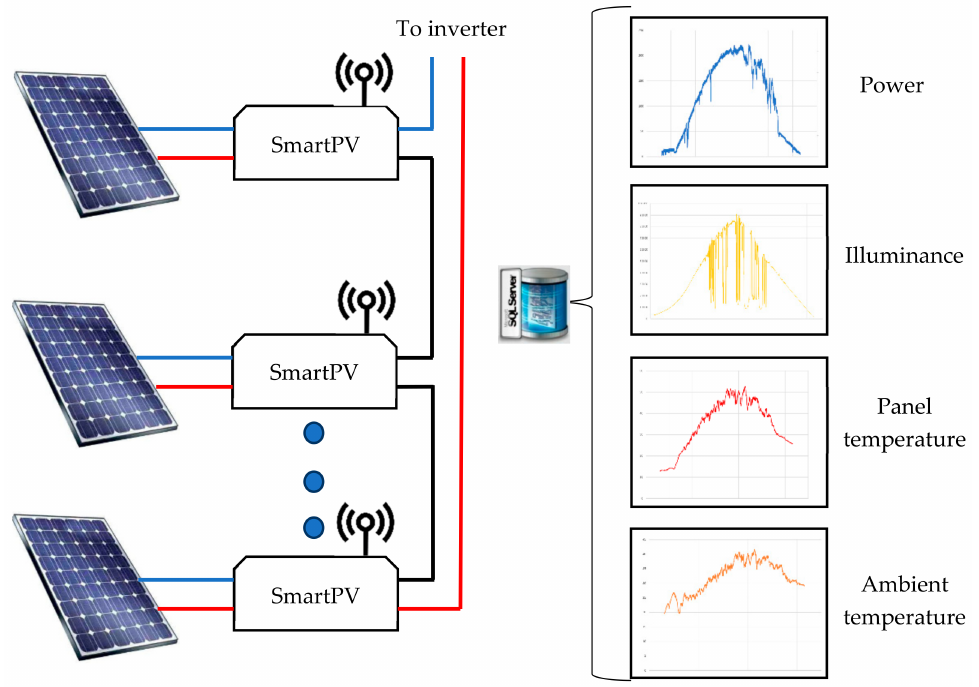
Figure 4. Method of data acquisition from PV